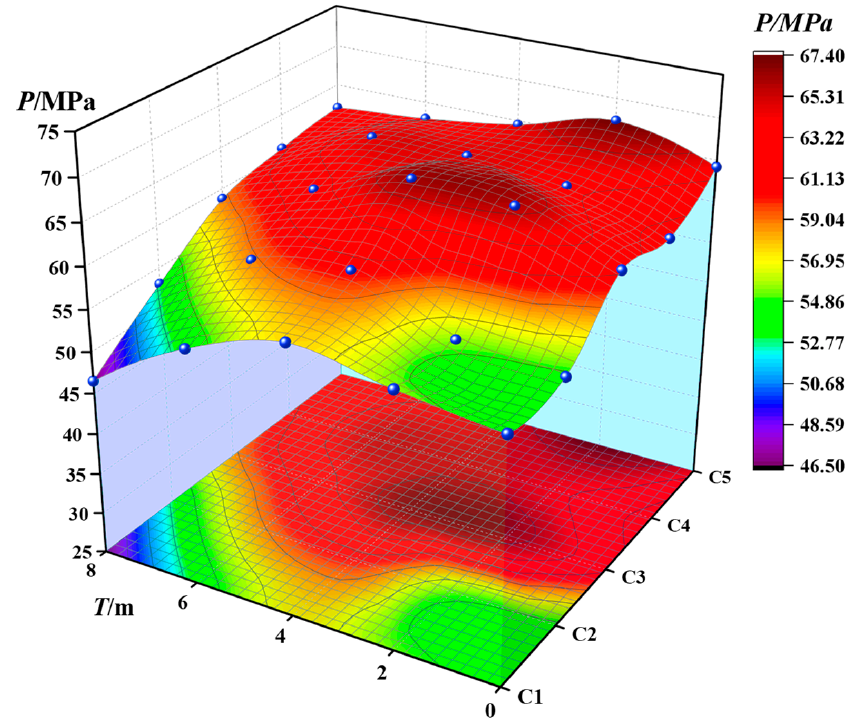
Figure 9. Spatial distribution of compressive strength.